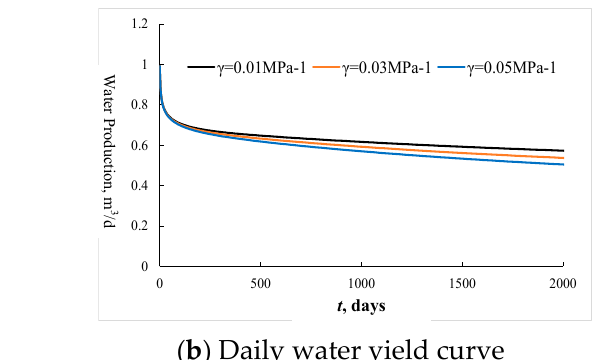
Figure 7 shows the influence of the outer boundary distance on the production dynamics. It can